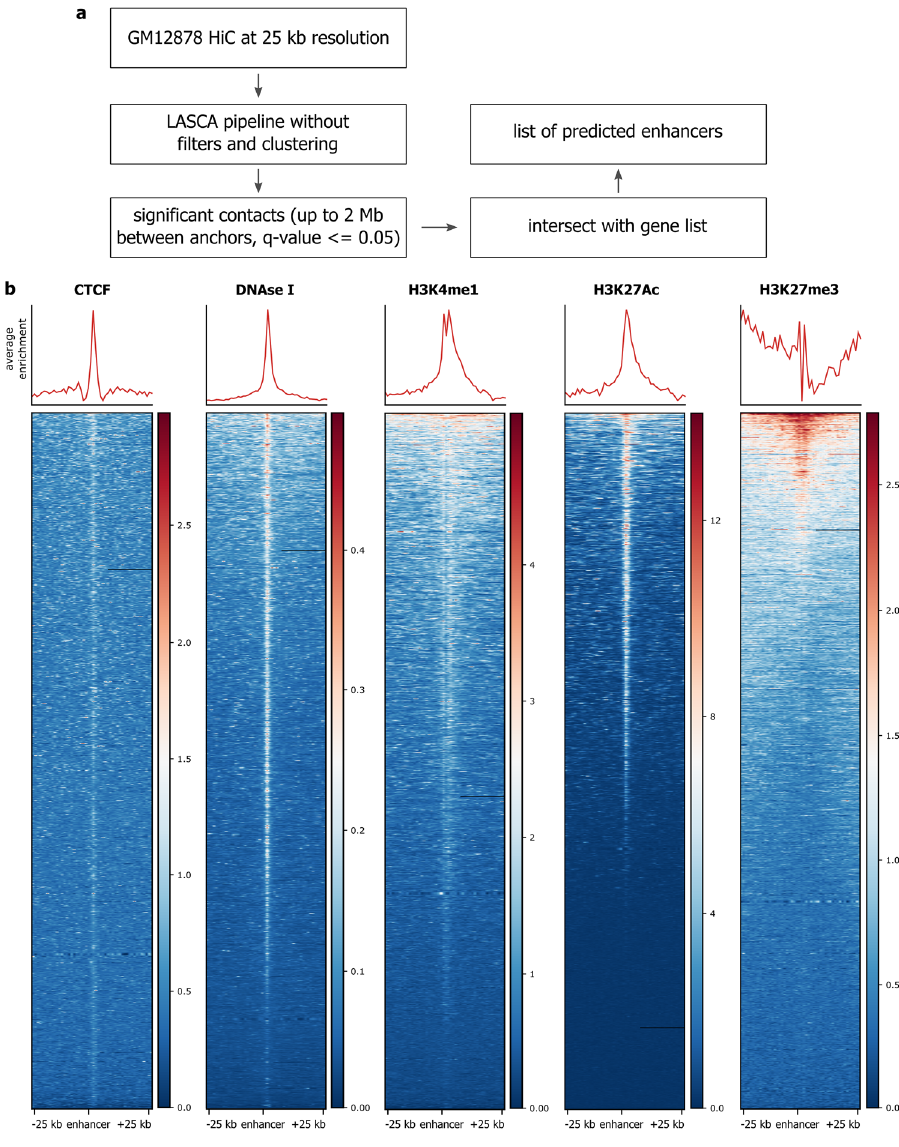
Figure 5. LASCA pipeline is suitable for identification of enhancer-promoter interactions. ( a ) Scheme showing enhancer-promoter interaction mapping using LASCA pipeline. ( b ) Epigenetic profiles around enhancers (+ / − 25 kb) identified by LASCA